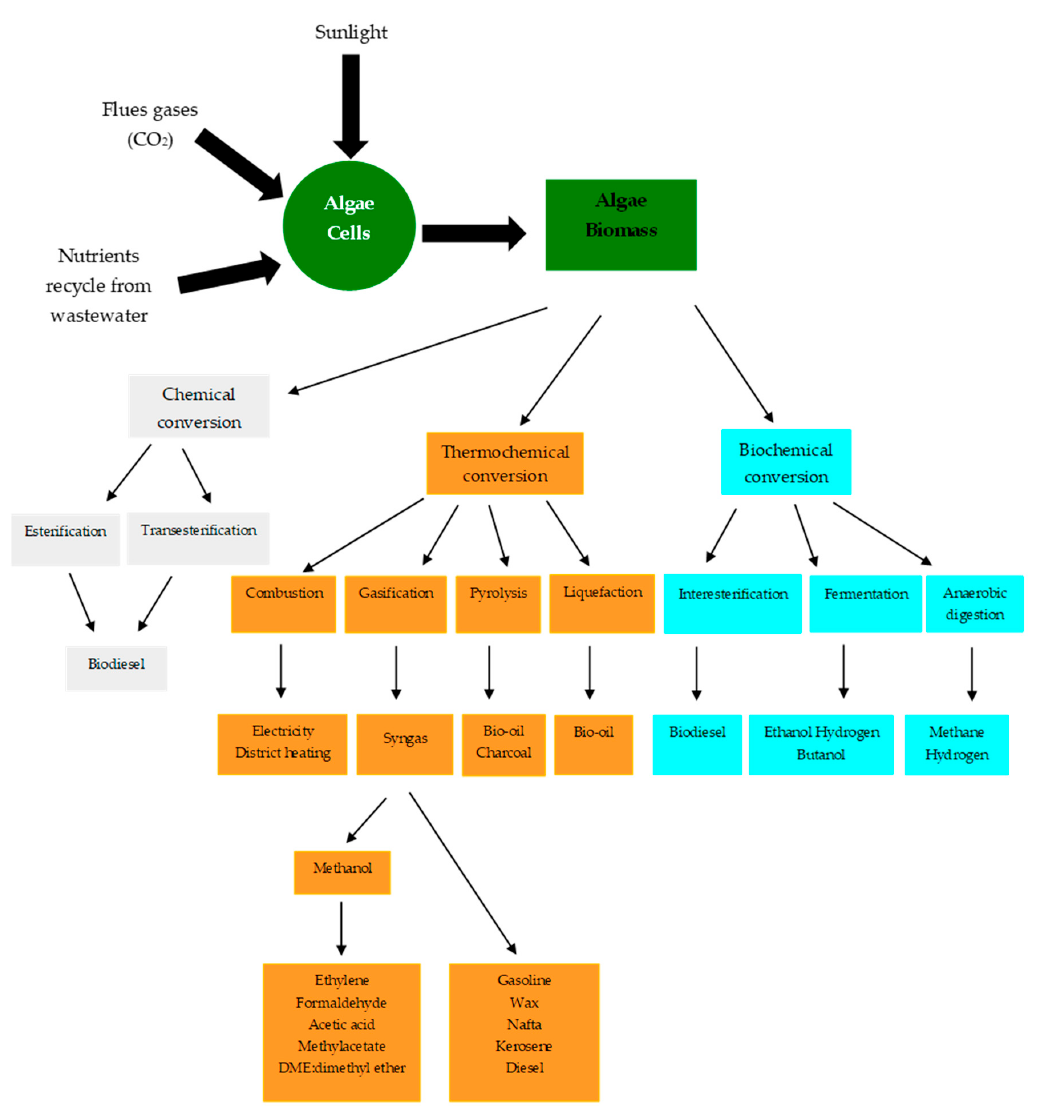
Figure 1. Algal biomass conversion pathways (modified from [84]).